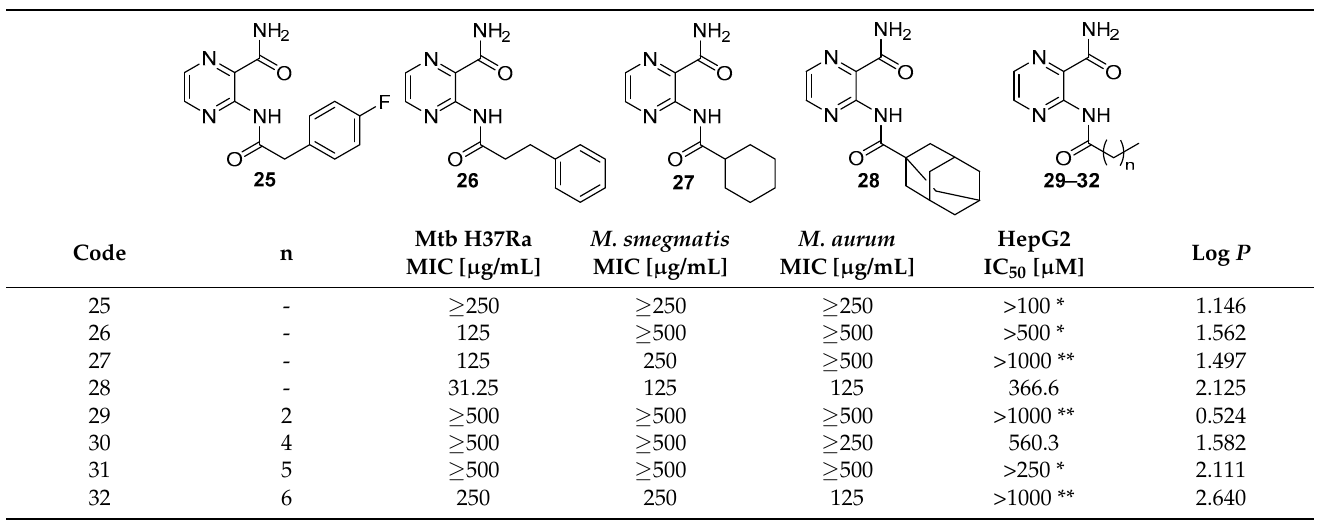
Table 2. Antimycobacterial activity and HepG2 cytotoxicity of compounds with phenylalkyl, alkyl, or cycloalkyl substituents.